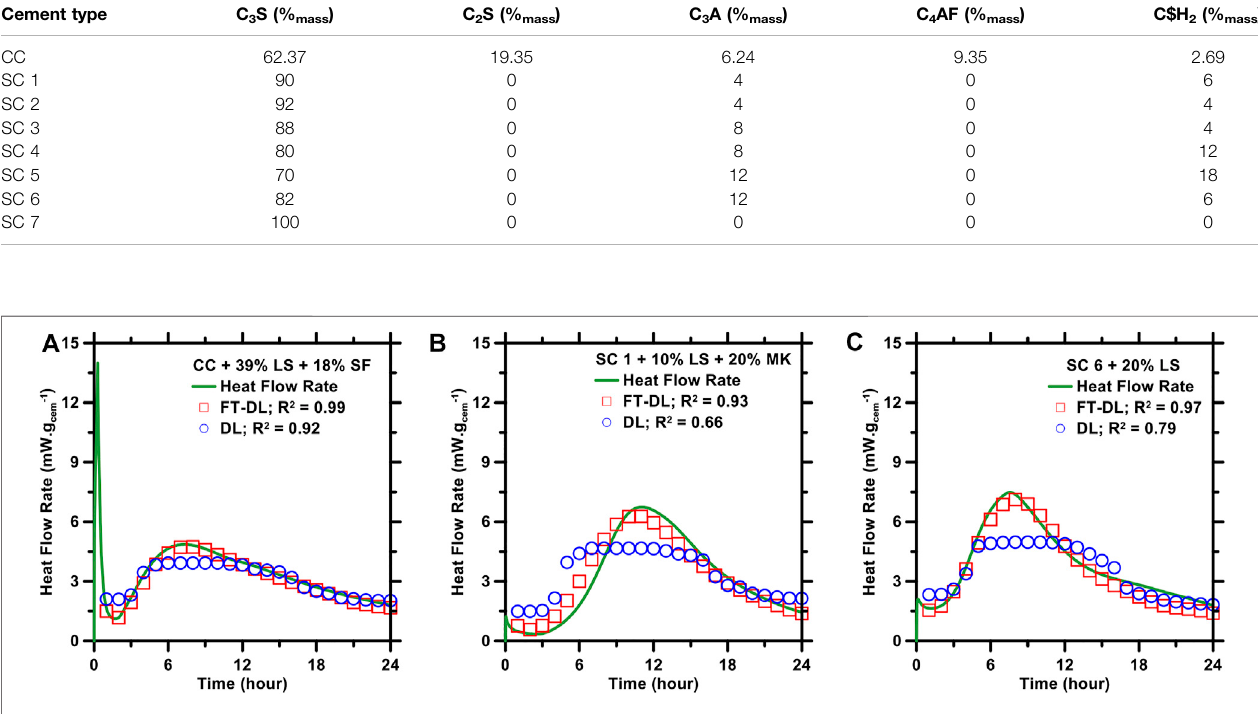
FIGURE5| TheFT-DLandDLmodels ’ predictionsofheat fl owratepro fi lesof: (A) (commercialcement(CC)+limestone(LS)+silicafume(SF)])paste; (B) [synthetic cement 1 (SC 1) + limestone (LS) + metakaolin (MK)] paste; and (C) [synthetic cement 6 (SC 6) + limestone (LS)] paste compared against experimental measurements. Coef fi cient of determination ( R 2 ) of each prediction is shown in the legends.